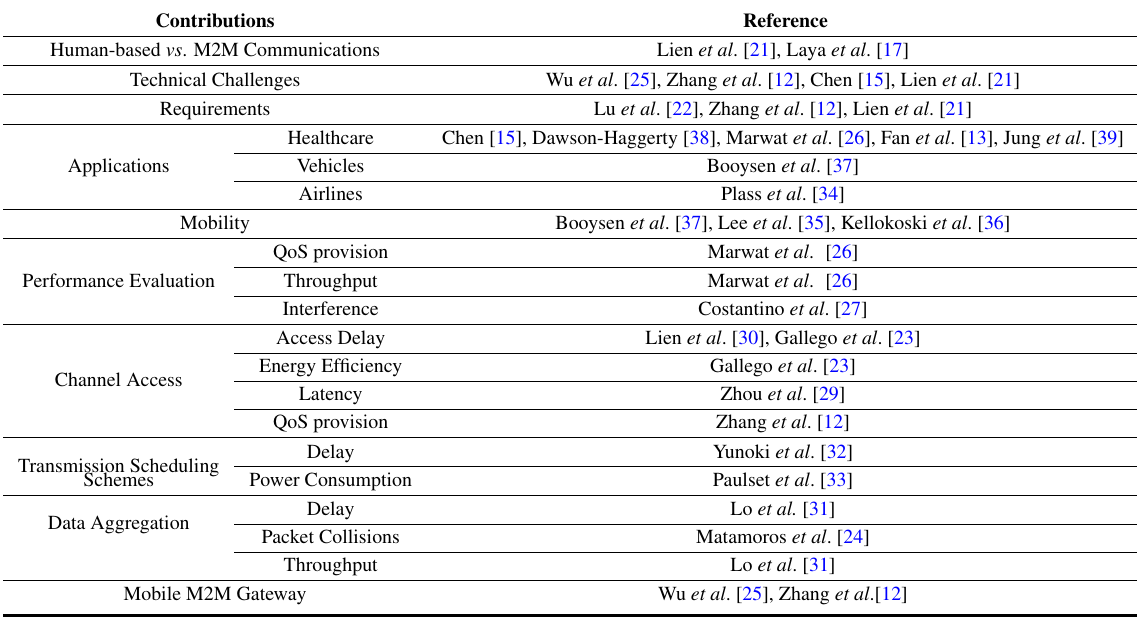
Table 1. Summary of survey of literature and challenges presented in the